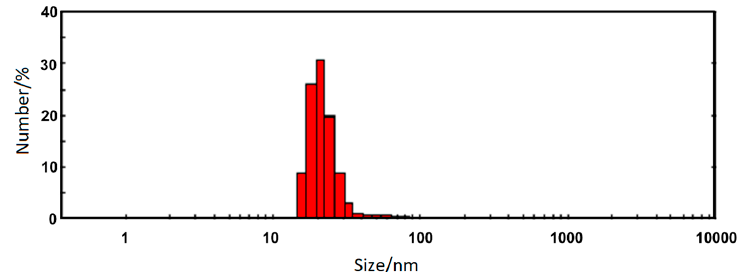
Figure 4. Distribution profiles of the hydrodynamic diameters ( D h ) obtained from DLS measurements for the nanorods.